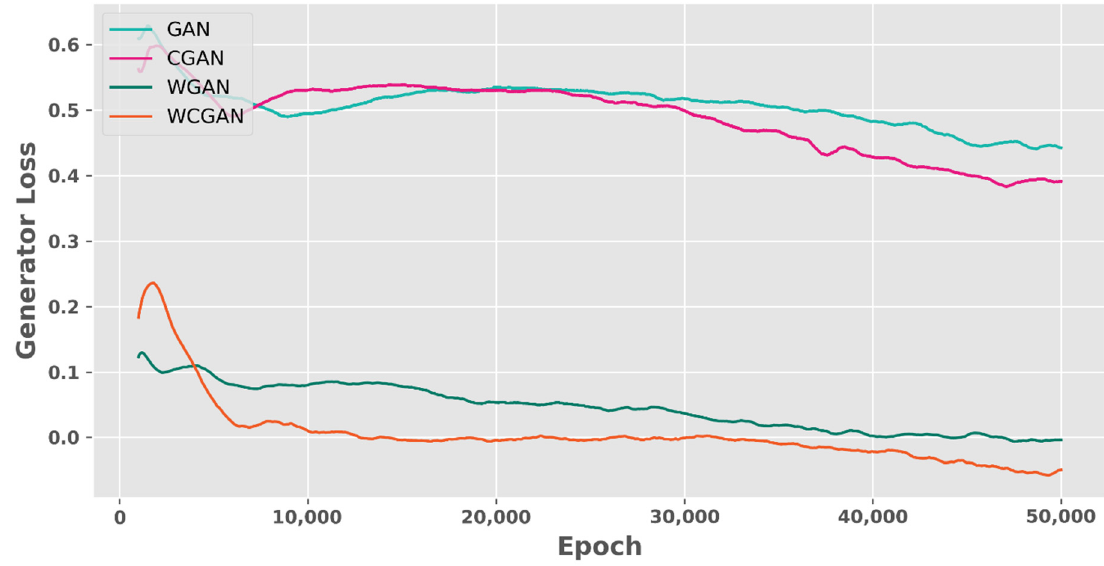
Figure 7. Generator loss values of our four models for each epoch.